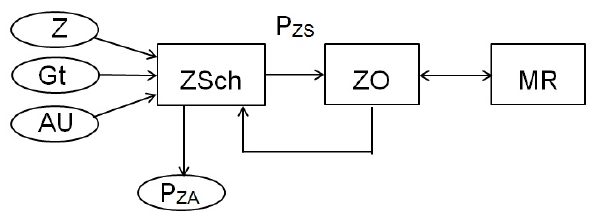
Figure 2. The main modules of the technological process hierarchical model. The ZSch module, based on the specified Gantt chart Gt, builds a task graph and assigns unit types for each task. A P ZS set of assigned units are transferred to the